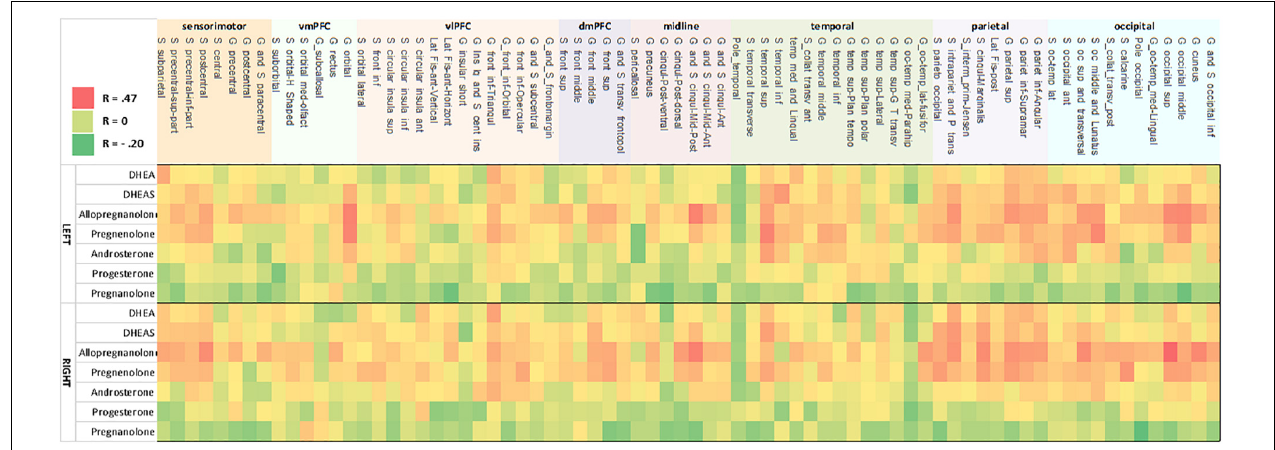
FIGURE 2 | Heat map of correlation between neurosteroid level and cortical thickness. Correlation strength between neurosteroid level ( y -axis) and cortical thickness ( x -axis) for the left hemisphere (upper heat map) and right hemisphere (lower heat map). The pattern shows concordant relationships among DHEAS, allopregnanolone, pregnenolone, and to a lesser extent with androsterone as well as concordant results between the left and right hemisphere. The strongest correlations are present in inferior frontal cortex, temporoparietal, occipitoparietal, and occiptiotemporal association cortices. Nomenclature of cortical structure is per definitions provided by Destrieux et al.